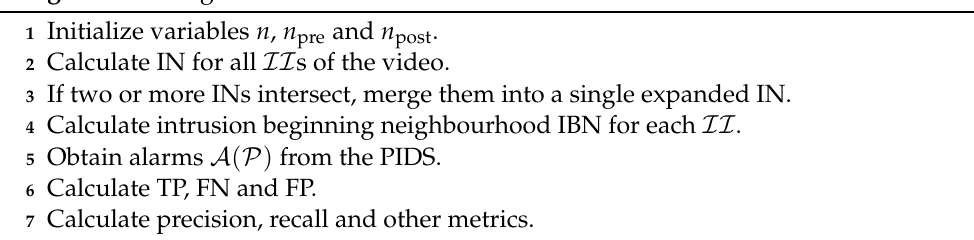
Algorithm 1: Edge-Level Evaluation of a